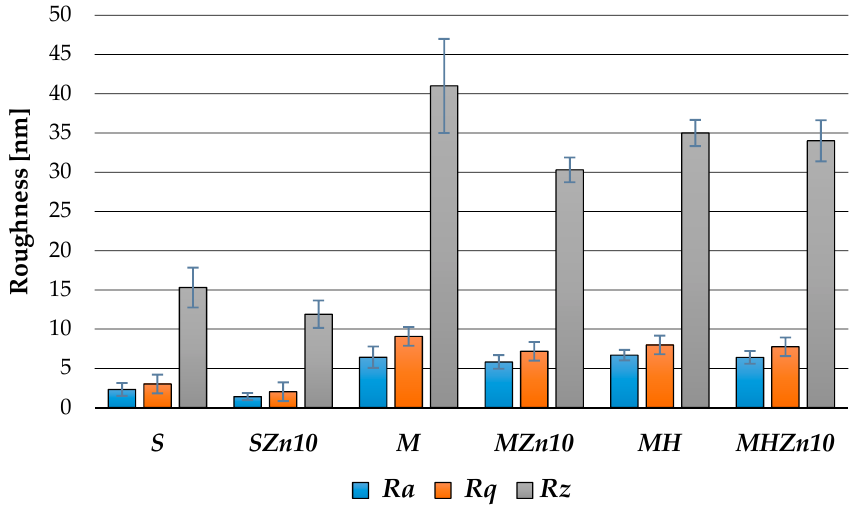
Figure 1. Roughness of coatings with and without Zn additive.